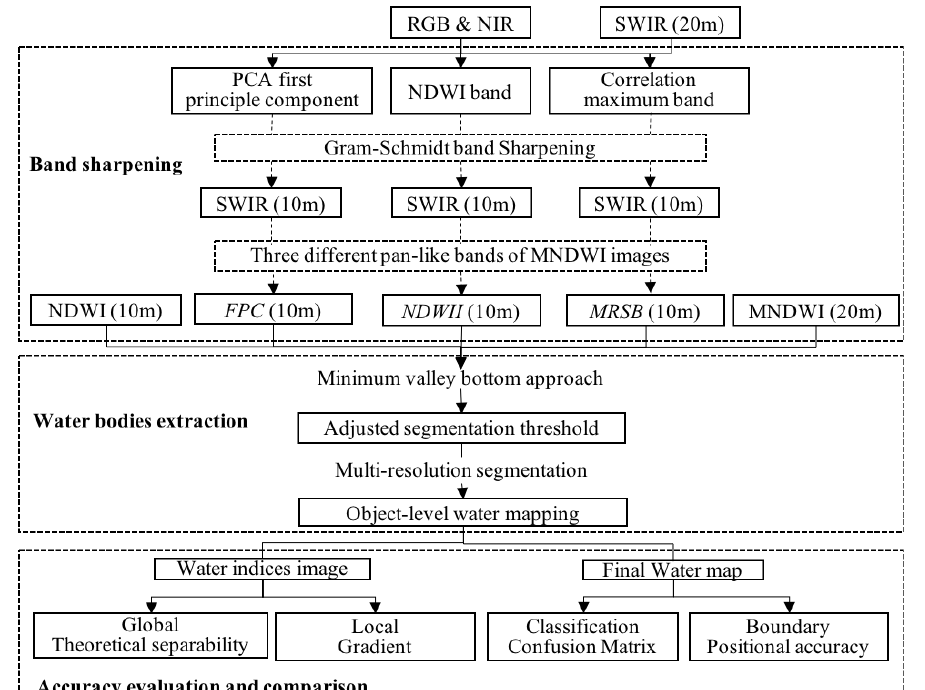
Figure 1. Workflow of the band sharpening and water mapping.